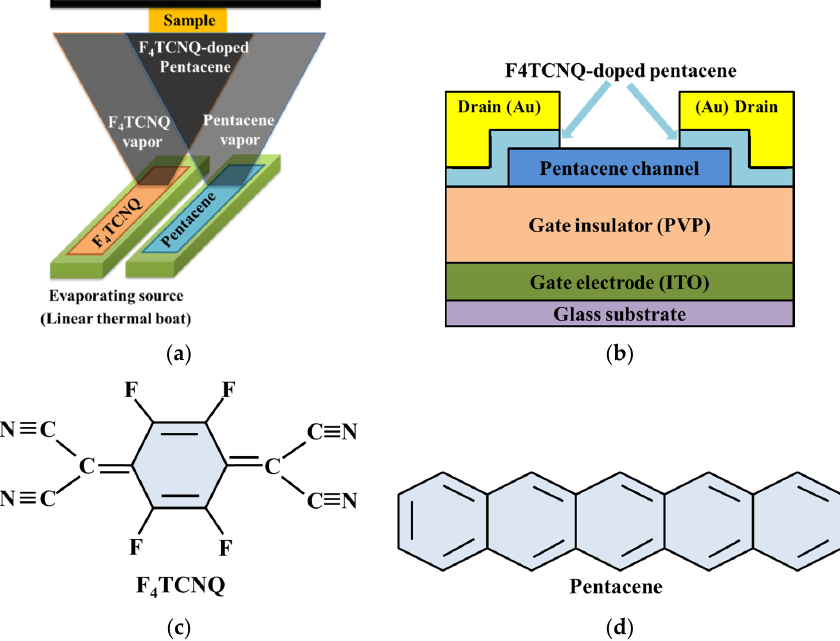
Figure 1. ( a ) a schematic diagram of the co ‐ evaporation process; ( b ) a schematic structure of the pentacene ‐ based organic thin ‐ film transistors (OTFTs) with F 4 TCNQ ‐ doped pentacene injection layer, and the molecular structures of ( c ) F 4 TCNQ and ( d ) pentacene, respectively.